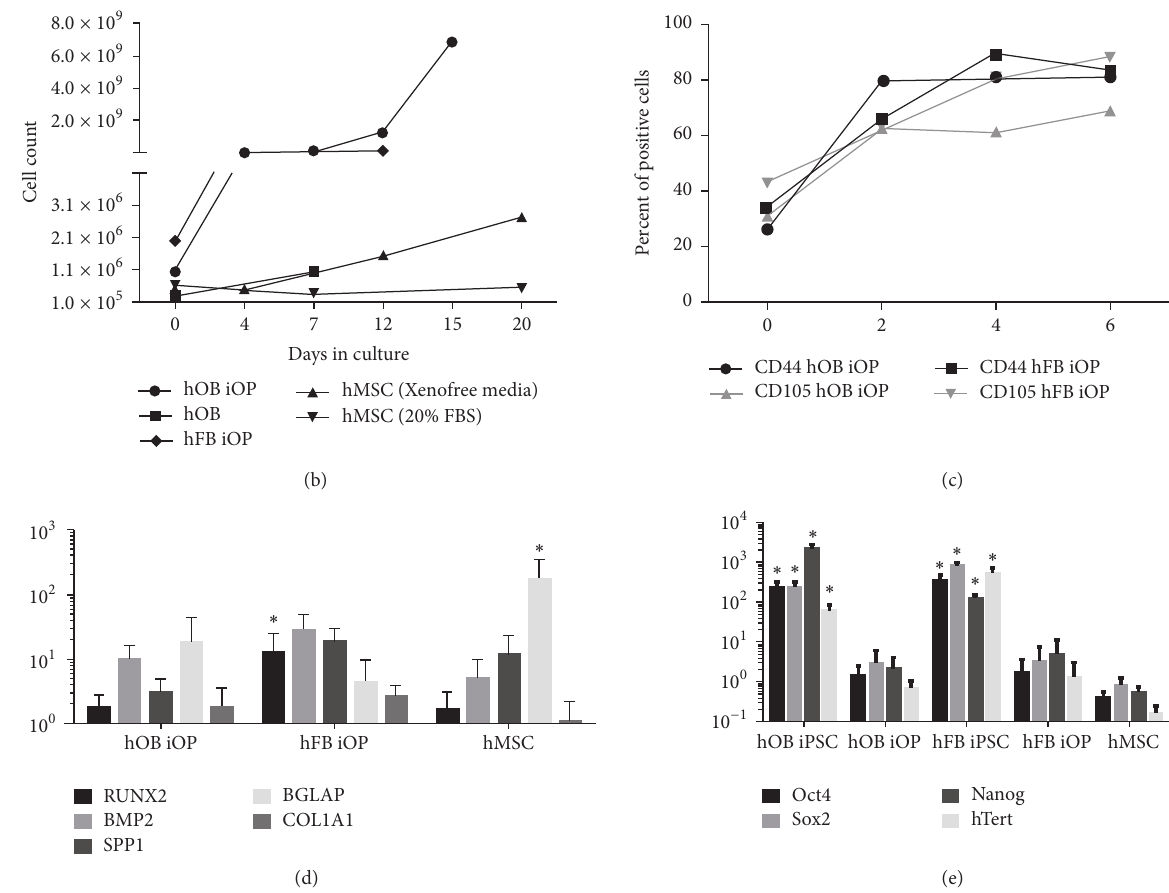
Figure 4: Induced osteoprogenitors (iOPs) cells differentiated from hOB-iPSC. (a) Flow cytometry analysis of iOPs and hMSCs revealed that the cells were positive for mesenchymal markers (CD29, CD44, CD90, CD105, and CD166) and negative for hematopoietic markers (CD14, CD31, and CD45) (black: CD marker expression, red: isotype control, and blue: unstained control). (b) Significantly ( 𝑃 < 0.05 ) faster growth kinetics of the hOB-iOPs and hFB-iOPs, as compared to hOBs and hMSCs in either 20% serum-containing media or Xenofree StemPro media at all time points. (c) Differentiation time of hOB-iPSCs to iOPs was assayed using flow cytometry for mesenchymal cell markers, CD44 and CD105. (d) iOPs were found to have similar levels of osteogenic related genes, RUNX2, BMP2, osteocalcin, and COL1A1 as compared to hMSCs ∗ indicates significant difference from the hOB-iOPs ( 𝑃 < 0.05 ). iOPs downregulated all pluripotency genes, Oct4, Sox2, Nanog, and hTERT indicating successful differentiations. ∗ indicates significant difference from the iPSC ( 𝑃 < 0.05